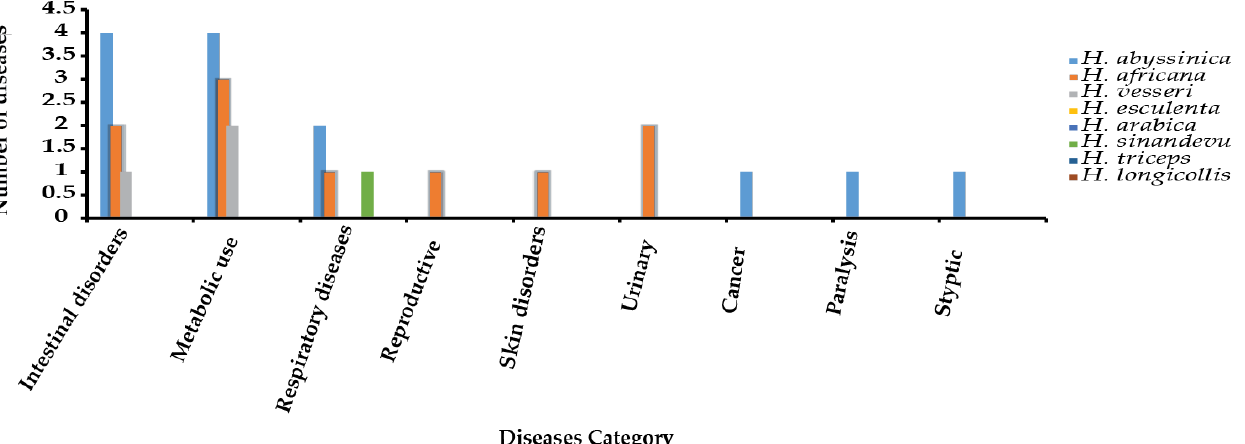
Figure 4. Utilized plant parts of Hydnora species.